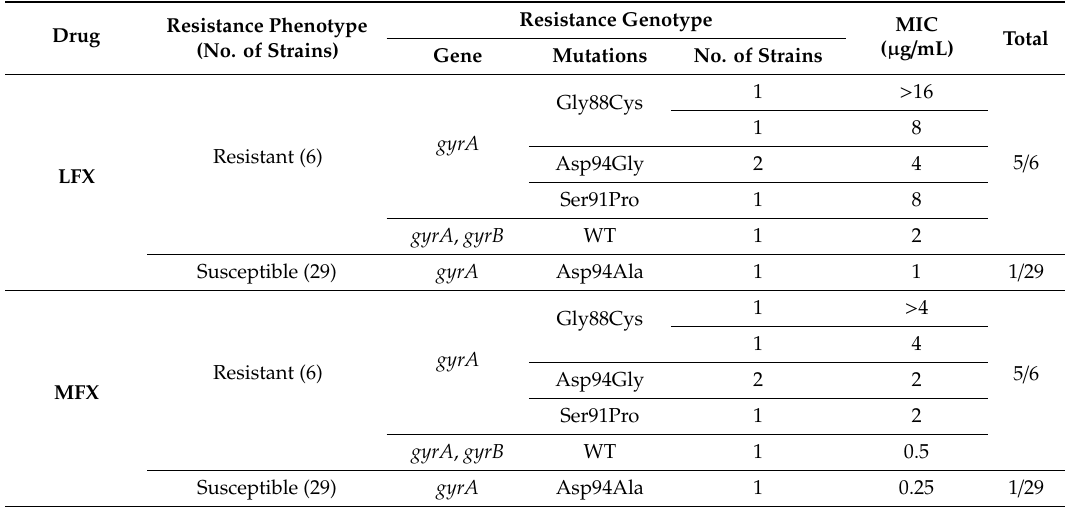
Table 3. Fluoroquinolone resistance determinant mutations in 35 rifampicin-resistant Mycobacterium tuberculosis strains [26,27].